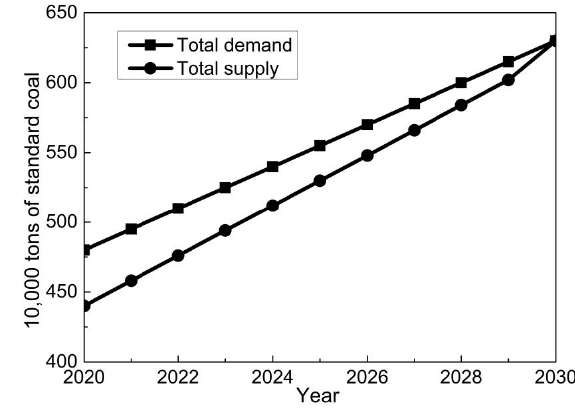
Fig. 10 Forecasting trend of oil supply and demand